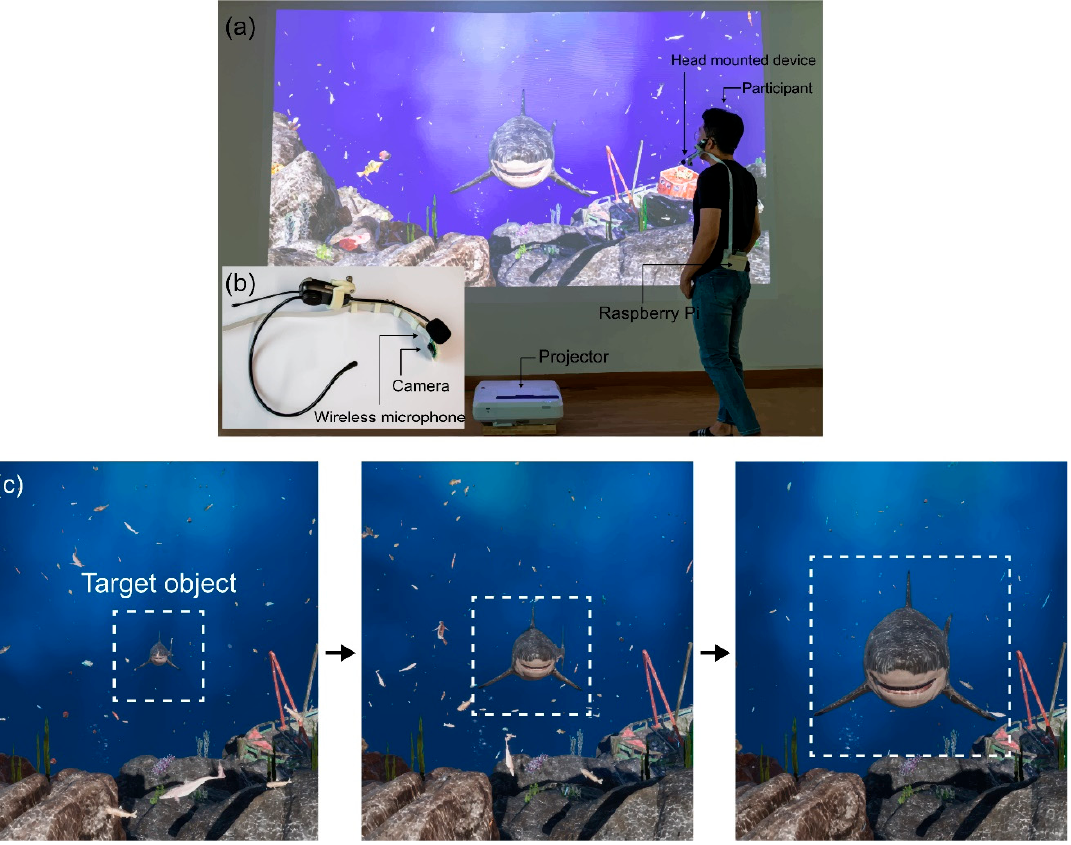
Figure 8. ( a ) Participant in the real-world interaction environment; ( b ) head-mounted device design; ( c ) target object approaching as a result of speech interaction.